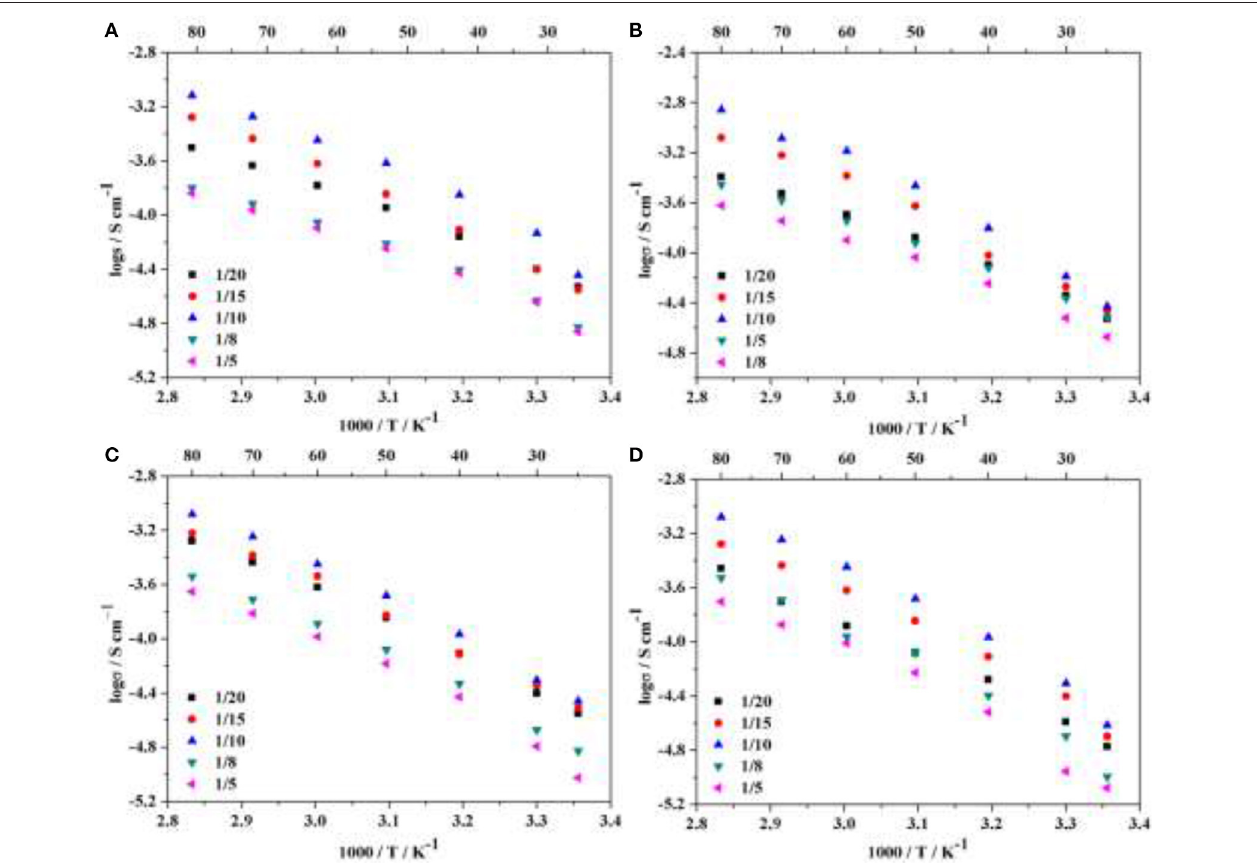
FIGURE 4 | Temperature-dependent ionic conductivity of HPEs with various POSS contents at different LiTFSI concentrations: (A) 2.5 wt.% POSS, (B) 5 wt.% POSS, (C) 7.5 wt.% POSS, (D) 10 wt.% POSS.